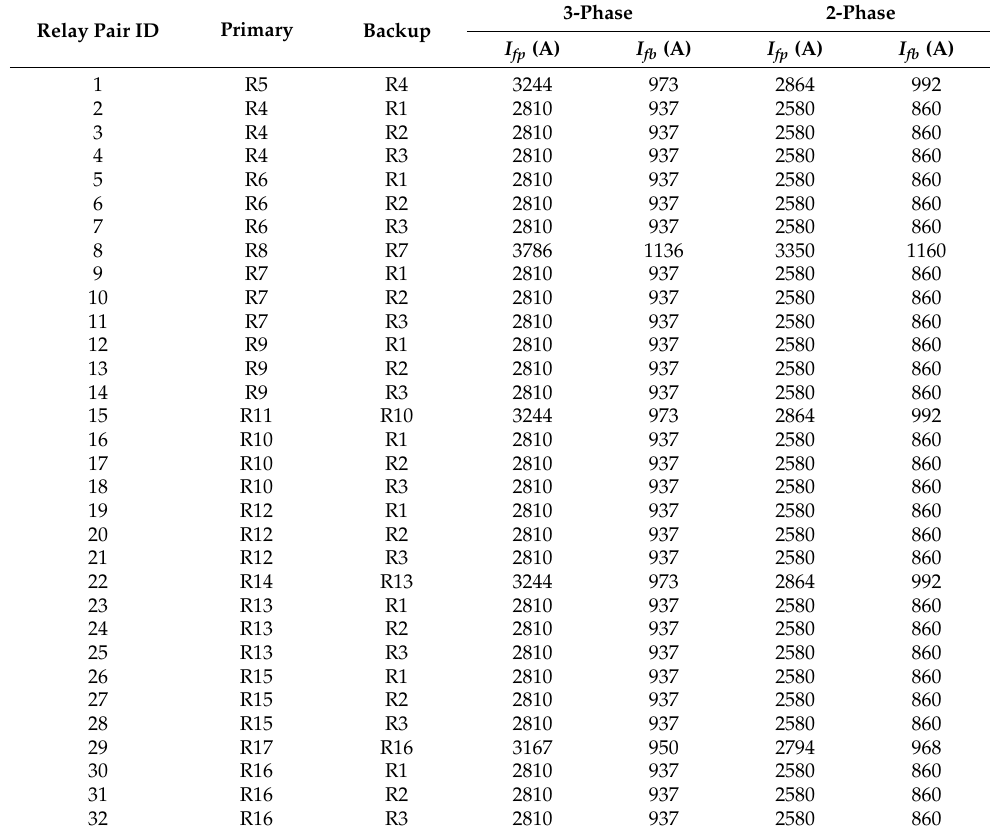
Table A7. Max-Fault Conditions (3 DGs are in service with Bus Coupler 1 and Bus Coupler 2 closed).